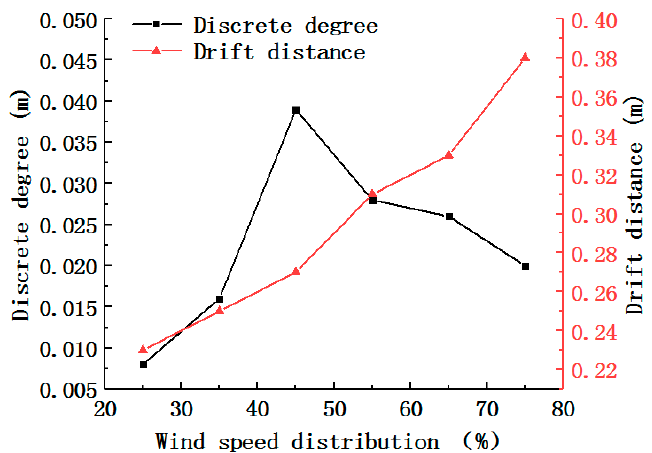
Figure 13. Experimental results for different wind speed distributions.